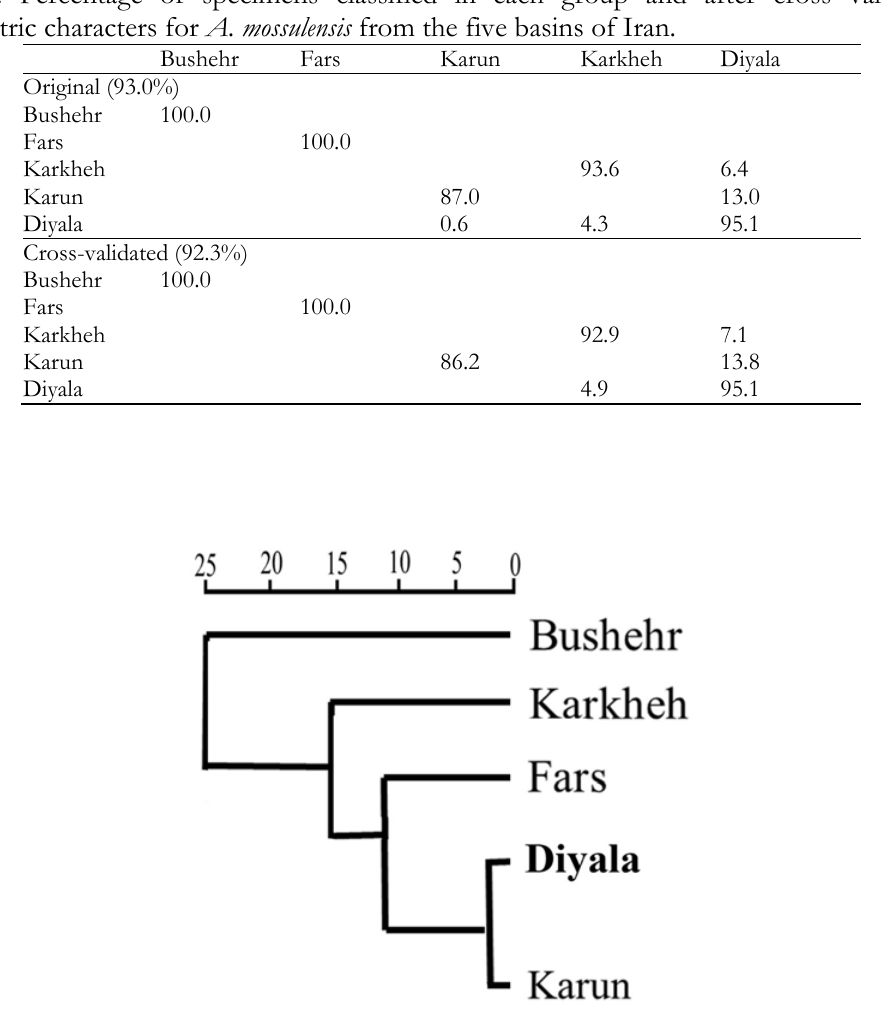
F IGURE 6. Dendrogram derived from cluster analyses of 12 meristic characters on the basis of Euclidean distance for A. musselensis